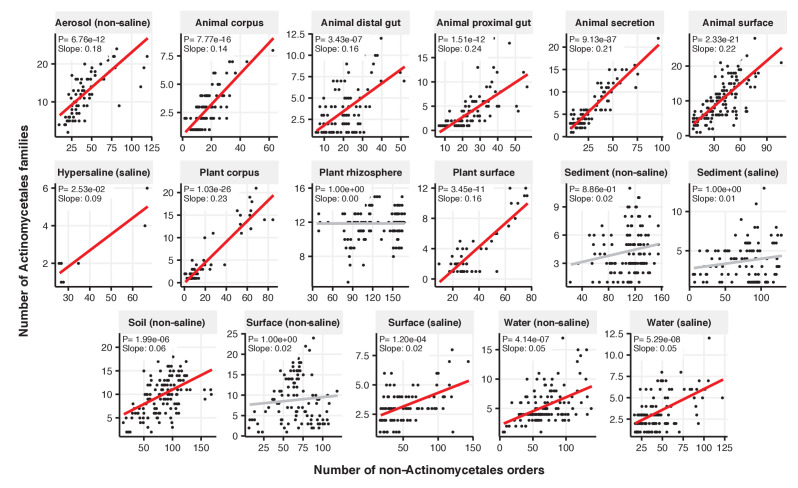
Focal-lineage diversity as a function of community diversity across biomes in Actinomycetales.Linear models are shown for the number of families per order (y-axis) as a function of community diversity (non-focal orders, x-axis) in each of the 17 environments (EMPO3 biomes). Only environments containing the focal lineage are shown. Significant positive diversity slopes are shown in red (linear models, p<0.05, Bonferroni corrected for 17 tests), and non-significant in grey.